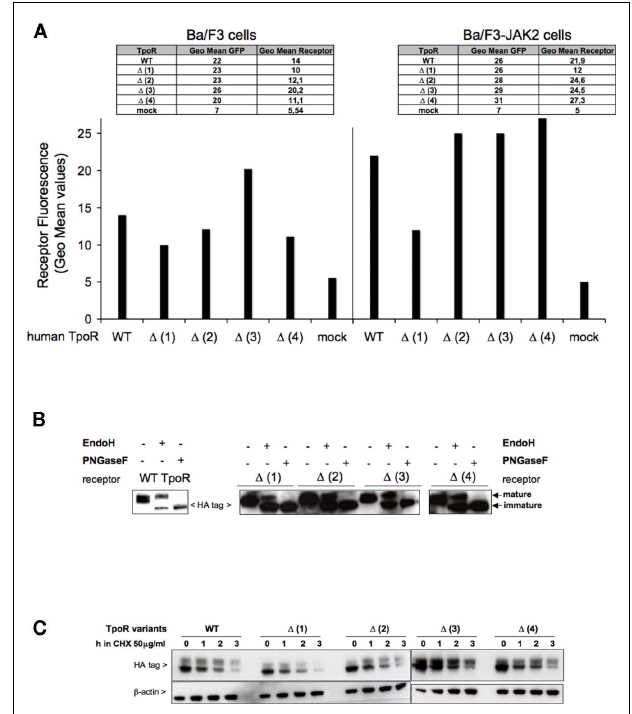
FIGURE 2 | Effect of single N-glycosylation site removal on the cell surface levels and stability of humanTpoR. (A) Sorted Ba/F3 parental or Ba/F3-JAK2 cells, expressingTpoR variants defective in one N-glycosylation site [ Δ (1), Δ (2), Δ (3), Δ (4)] were tested for cell surface levels using anti-HA antibody based flow cytometry. Similar results were obtained in four independent experiments, on two different cell lines obtained for each TpoR variant.The differences between the cell surface levels of Δ (1)TpoR in Ba/F3 and Ba/F3-JAK2 cells were statistically significant when compared with the levels ofWTTpoR ( p = 0.006 and p = 0.0086, respectively). (B) HEK293 cells were plated in 6-well plates and transiently transfected with 3 μ g of each of the indicatedTpoR variants.Twenty-four hours post-transfection cells were lysed and treated with EndoH or PNGaseF or left untreated and subjected toWestern blot analysis. Membranes were probed with anti-HA. Similar results were obtained in three different experiments. (C) A pool of the cell lines used in (A) were treated at 37˚C with 50 μ g/ml cycloheximide (CHX) over different time periods then